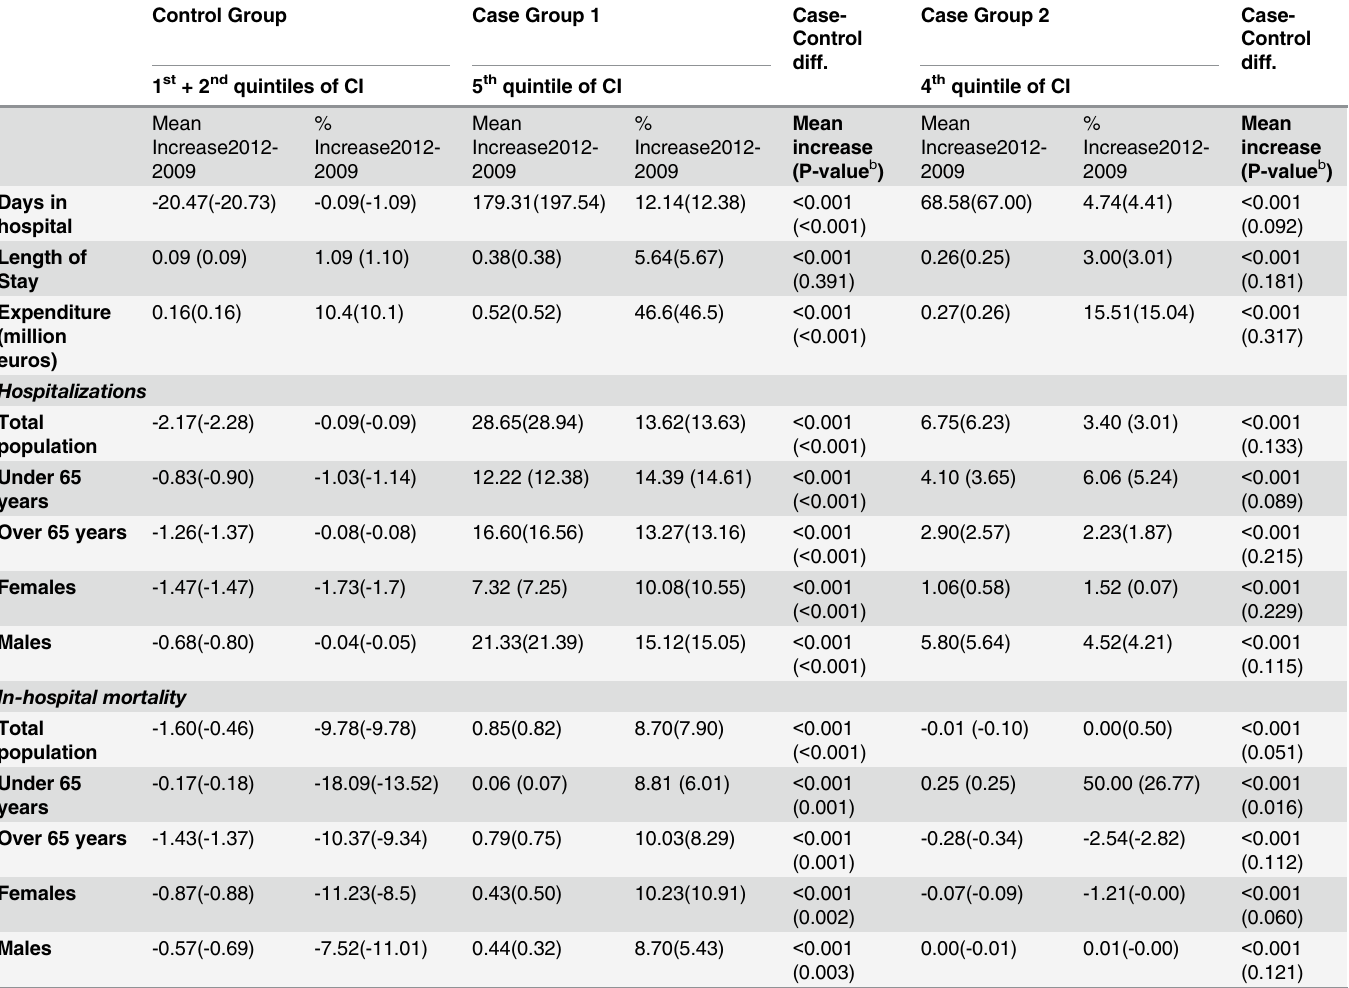
Table 2. The difference-in-differences analysis of the predicted and actual (in parenthesis) values a .